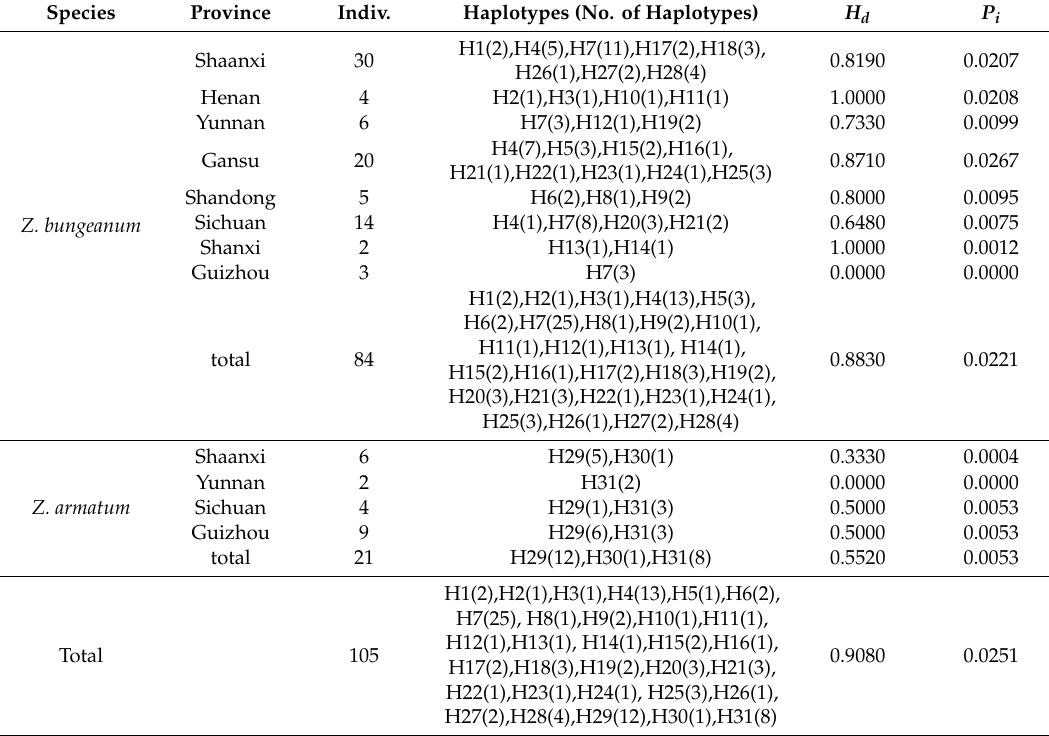
Table 1. Locations of sample collection, sample size, haplotype distribution, estimates of haplotype diversity ( H d ) and nucleotide diversity ( P i ) of Chinese pepper used in this